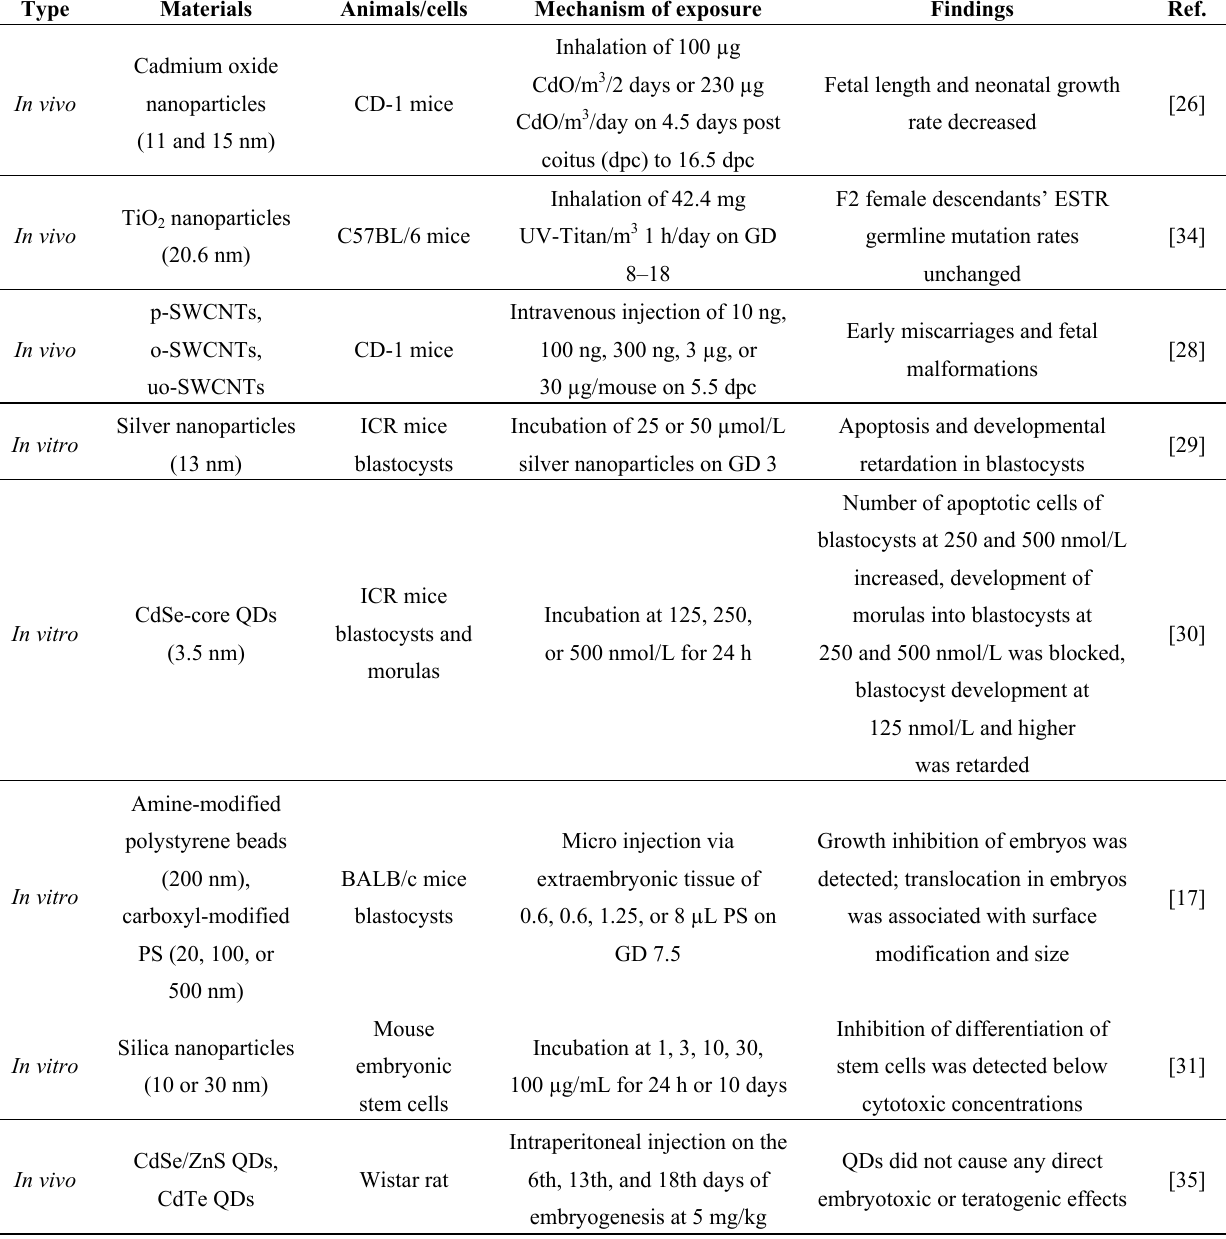
Table 2. Developmental toxicity of nanoparticles.